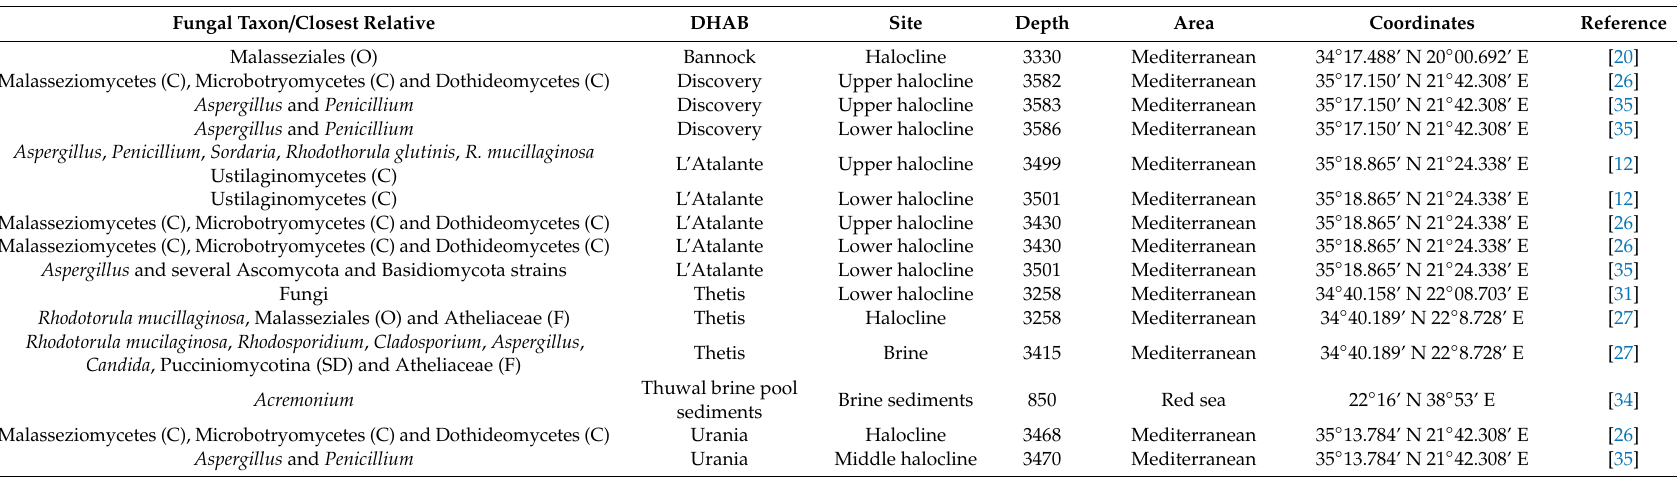
Table 1. List of fungal taxa identified in deep-sea hypersaline anoxic basins. Taxa are expressed as Sub-Division (SD), Order (O), Class (C) and Family